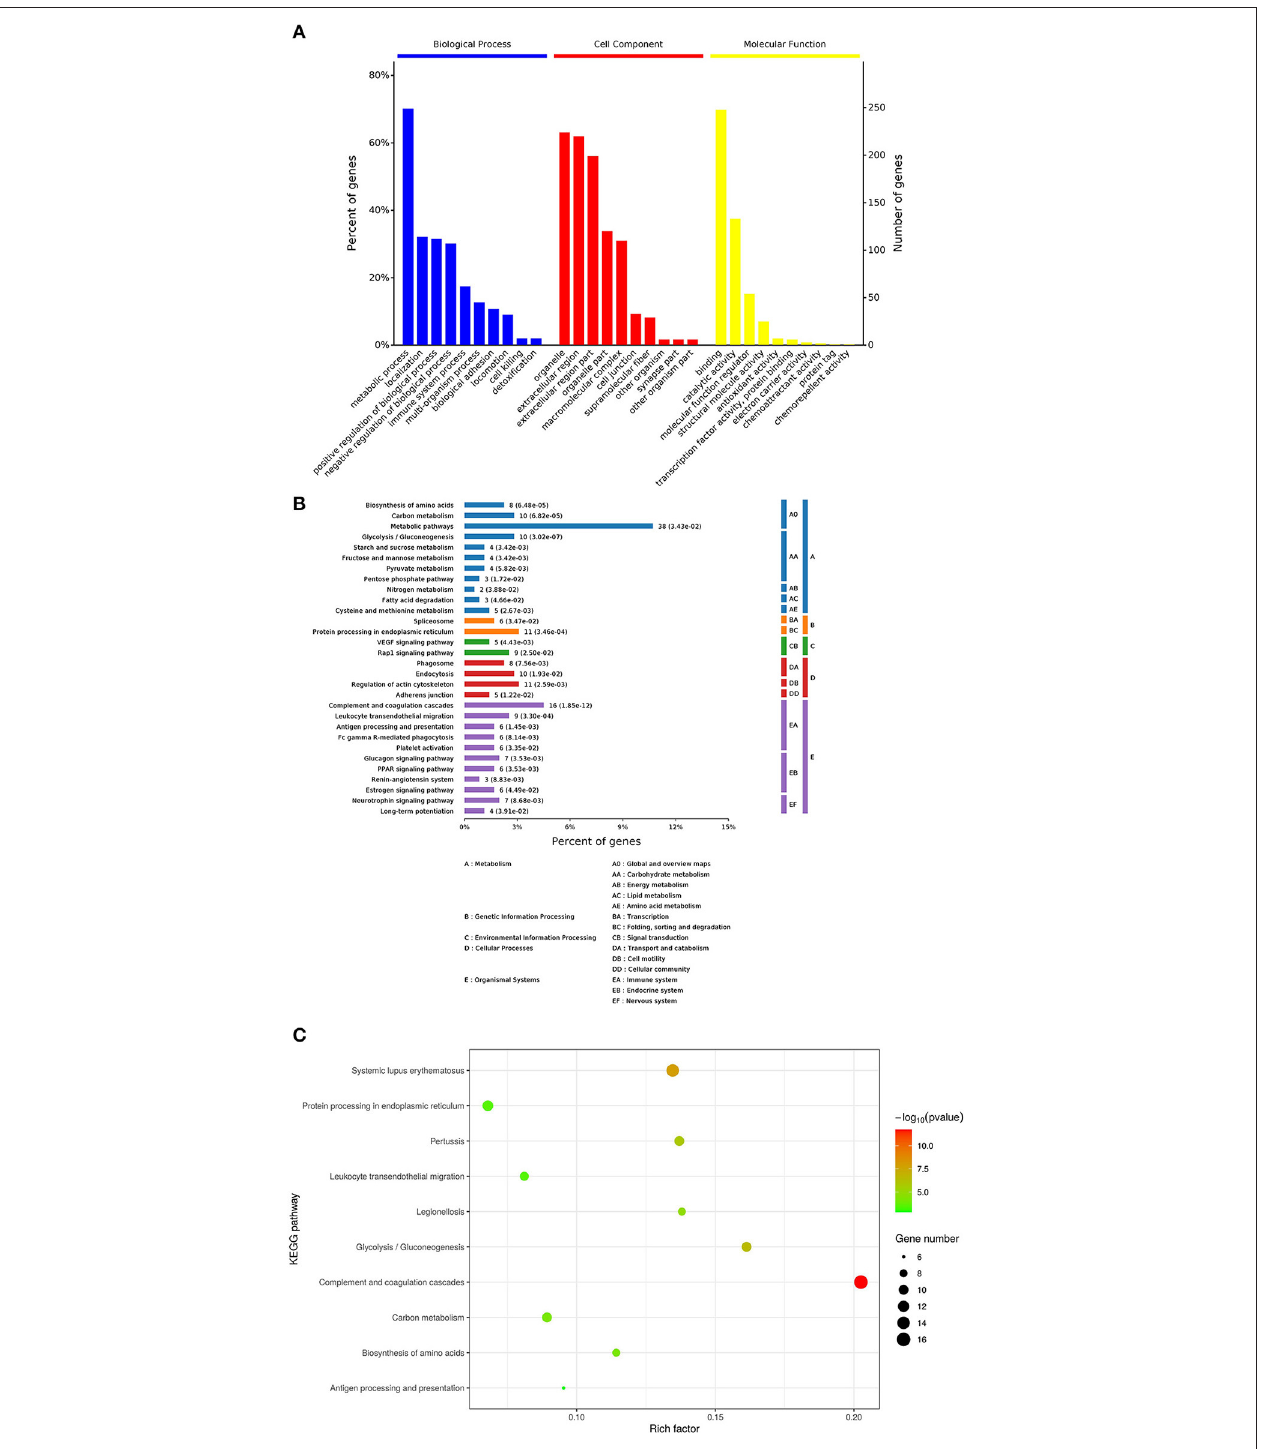
FIGURE 2 | Enrichment analysis of the vesicular fluid by Proteomics. (A) By gene ontology, (http://www.geneontology.org/) in the GO database, the enrichment analysis of biological processes (BP), cell components (CC), and molecular functions (MF) is significant. The abscissa indicates the enrichment to GO functional classification. The figure shows the enrichment analysis results of BP, CC, and MF. (B,C) Kyoto Encyclopedia of Genes and Genomes (KEGG): the ordinate represents the top 10 significantly enriched KEGG pathways and the abscissa represents the enrichment factor of each KEGG pathway (rich factor ≤ 1). Enrichment factor indicates the proportion of the number of differentially expressed proteins involved in a certain KEGG pathway among all identified proteins; the color of bubbles indicates the significance of the enriched KEGG pathway.